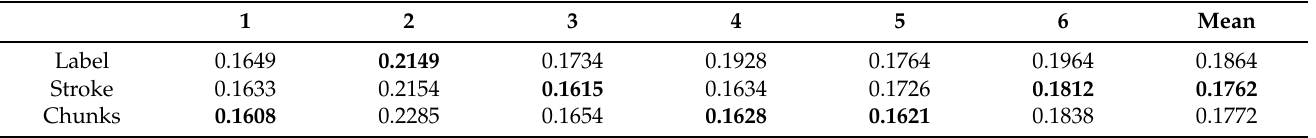
Table 5. Normalized TR error rates over the different